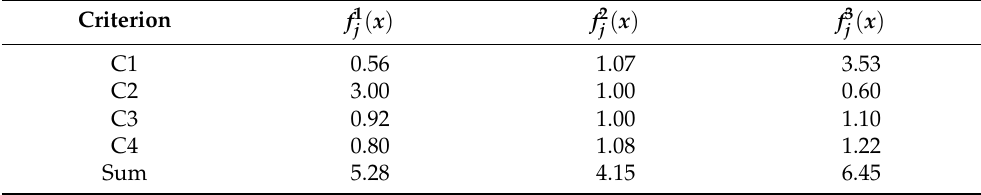
Table 9. Inverse of standard data.